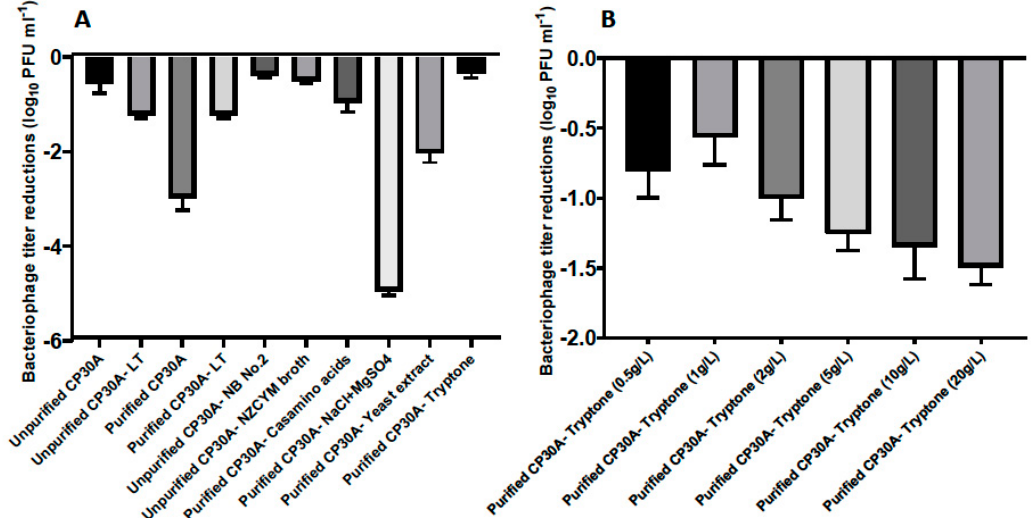
Figure 2. ( A ) Titer loss of lyophilized phage CP30A with di ff erent substances supplemented. The titer di ff erence was calculated between phage initial stock and after rehydration and recorded as the titer loss. Individual excipients were added to purified phage CP30A to a final concentration of 1 g L − 1 casamino acids, 5 g L − 1 sodium chloride, 1 g L − 1 magnesium sulfate, 5 g L − 1 yeast extract and 1 g L − 1 tryptone. ( B ) Titer loss of lyophilized phage with tryptone supplemented to di ff erent final concentrations. Error bars represent the standard deviation of the mean between three biological replicates.